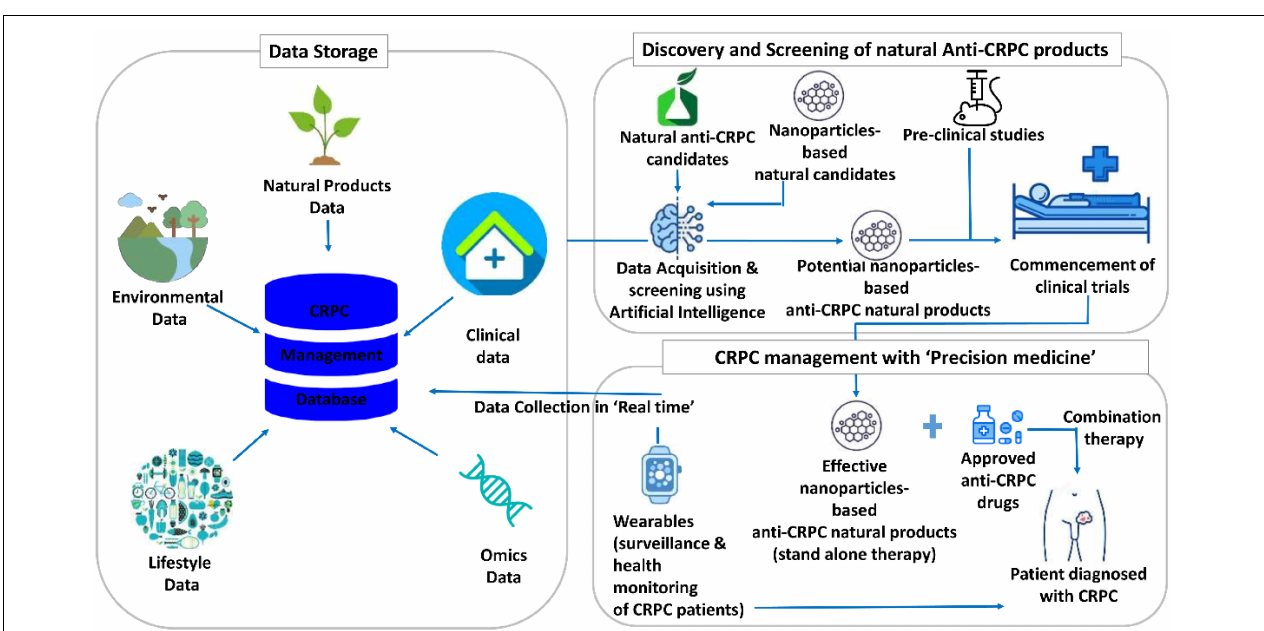
FIGURE 5 | Translational informatics model for castration-resistant prostate cancer (CRPC) management using nanoparticles-based anti-CRPC natural